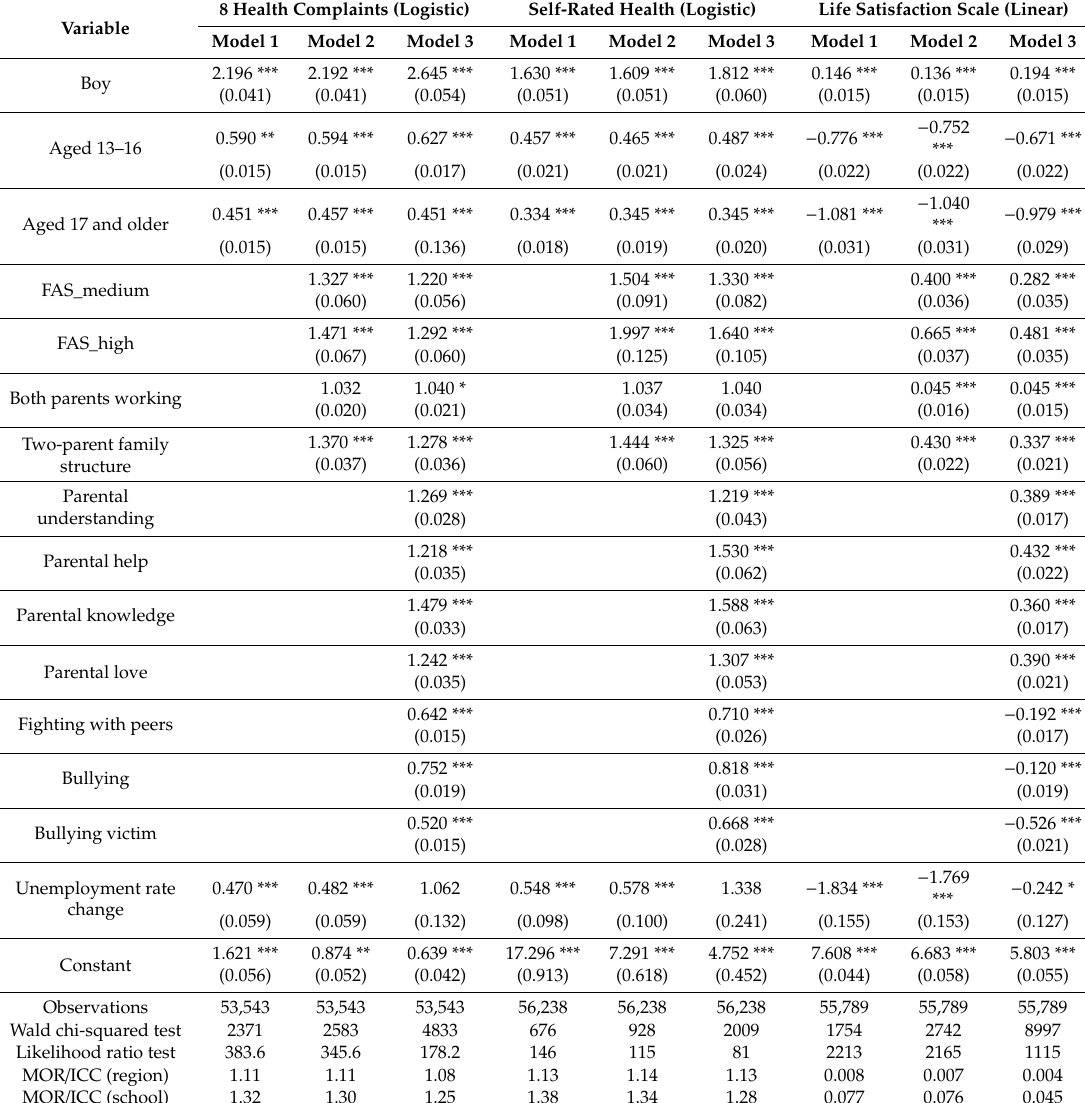
Table 4. Results from the multilevel logistic regressions on health complaints, self-rated health, and life satisfaction (odds ratios / coe ffi